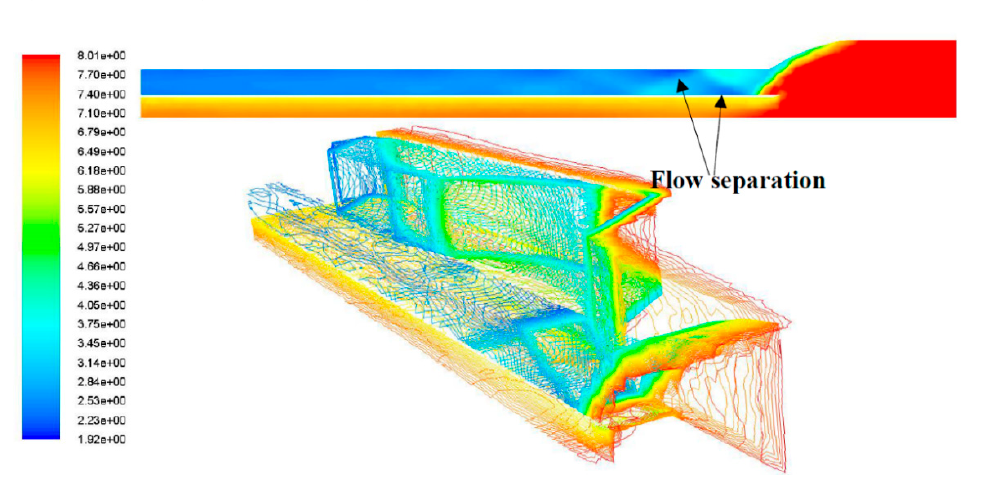
Figure 43. Mach contour of the rotated ramjet inlets at Mach 8.